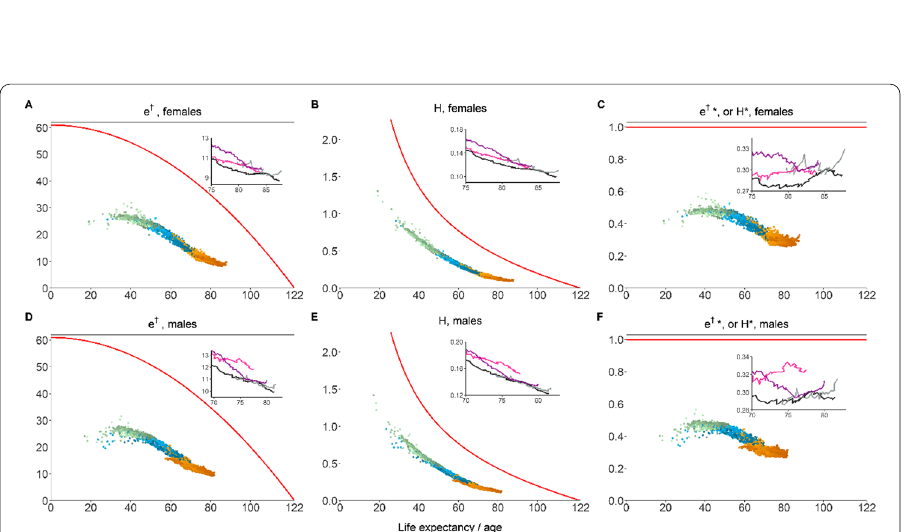
Fig. 11 Life expectancy and lifespan inequality for different inequality indicators, 1832–2020, HMD countries. A Life disparity for females; B life table entropy for females; C normalized life disparity or life table entropy for females; D life disparity for males; E life table entropy for males; F normalized life disparity or life table entropy for males. Red curve for maximal inequality given maximal lifespan 122, black line for Japan, dark magenta = line for Canada, pink line for Taiwan, grey line for Hong Kong. Normalized indices were calculated when maximal lifespan equals 122. (Source: Authors’ elaboration based on the HMD